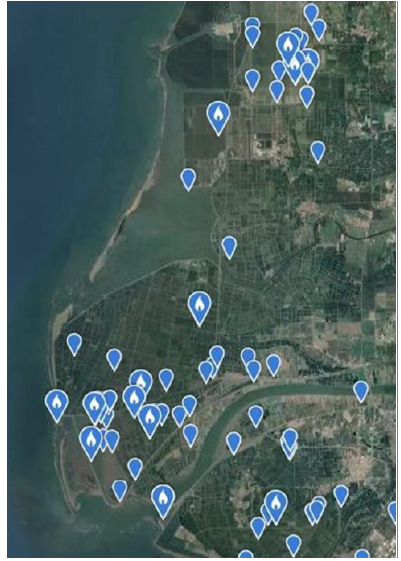
Figure 2. The distribution of the black-faced spoonbill.